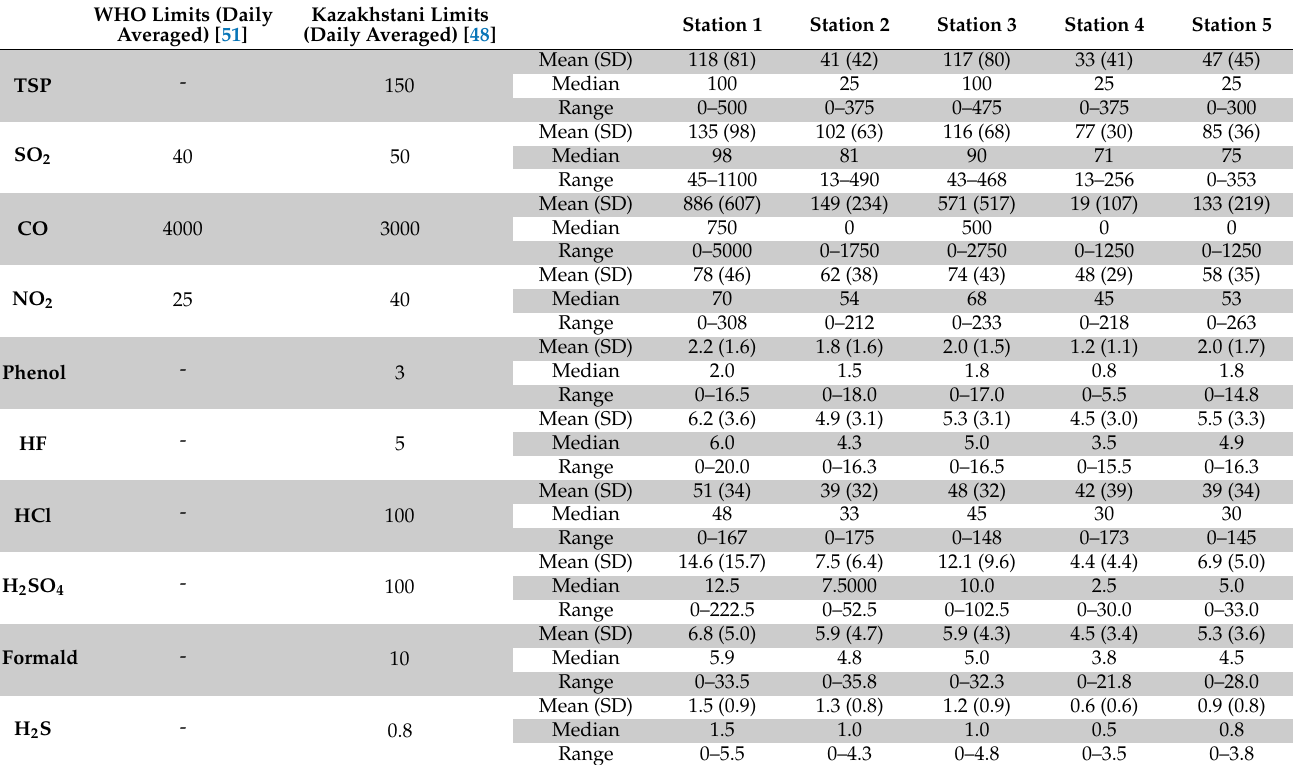
Table 3. Descriptive statistics of air quality during the warm seasons ( µ g m − 3